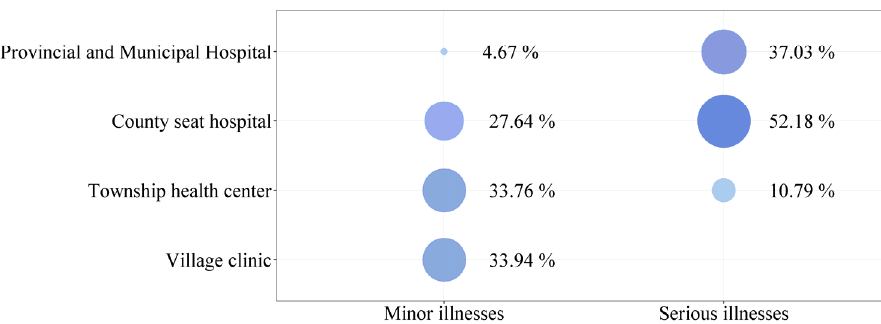
Figure 5. Reasons rural residents buy commercial houses in the county seat (Source: by the authors).